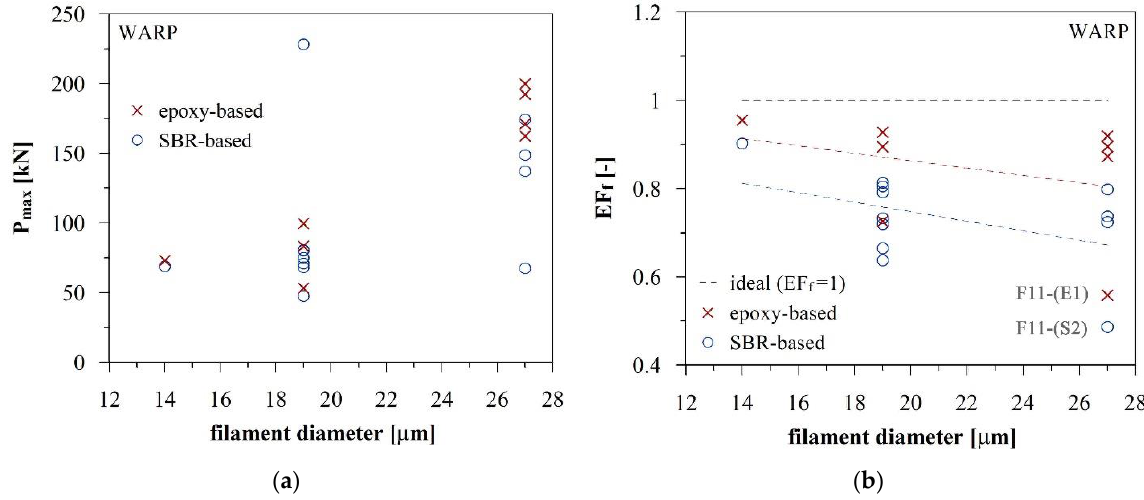
Figure 6. Average maximum load ( a ) and fabric efficiency ( b ) vs. filament diameters of the investigated textiles in the warp direction.